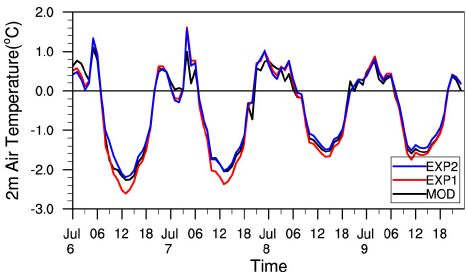
Fig. 6. The differences of air temperature at 2m above ground be- tween the oasis and the desert in a time series from the MOD, EXP1 and EXP2 simulations (the difference was calculated by subtracting the average air temperature over the desert from the average air tem- perature over the oasis).